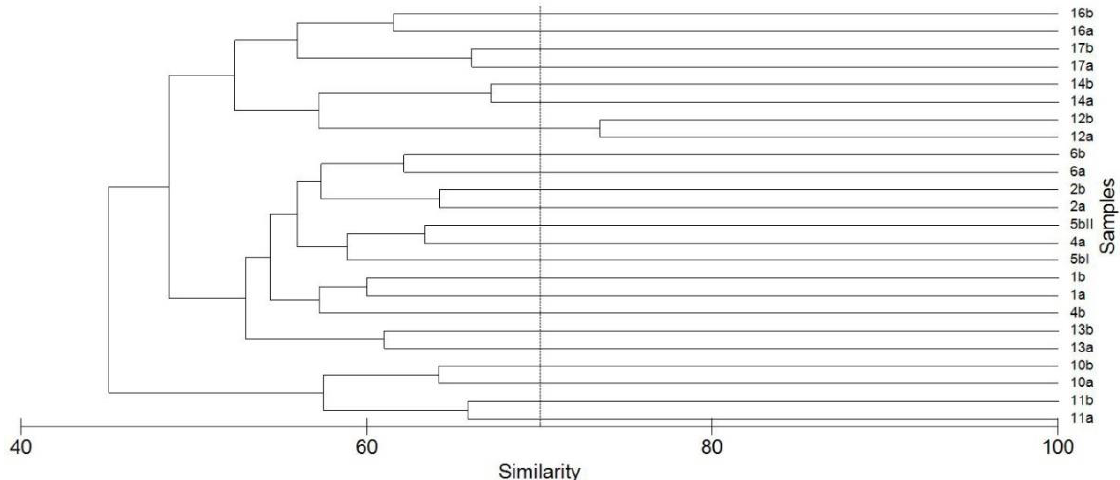
Figure 36. Similarity between the epiphytic diatom assemblages from Revillagigedo Archipelago according to the Bray– Curtis index based on the presence/absence of taxa.